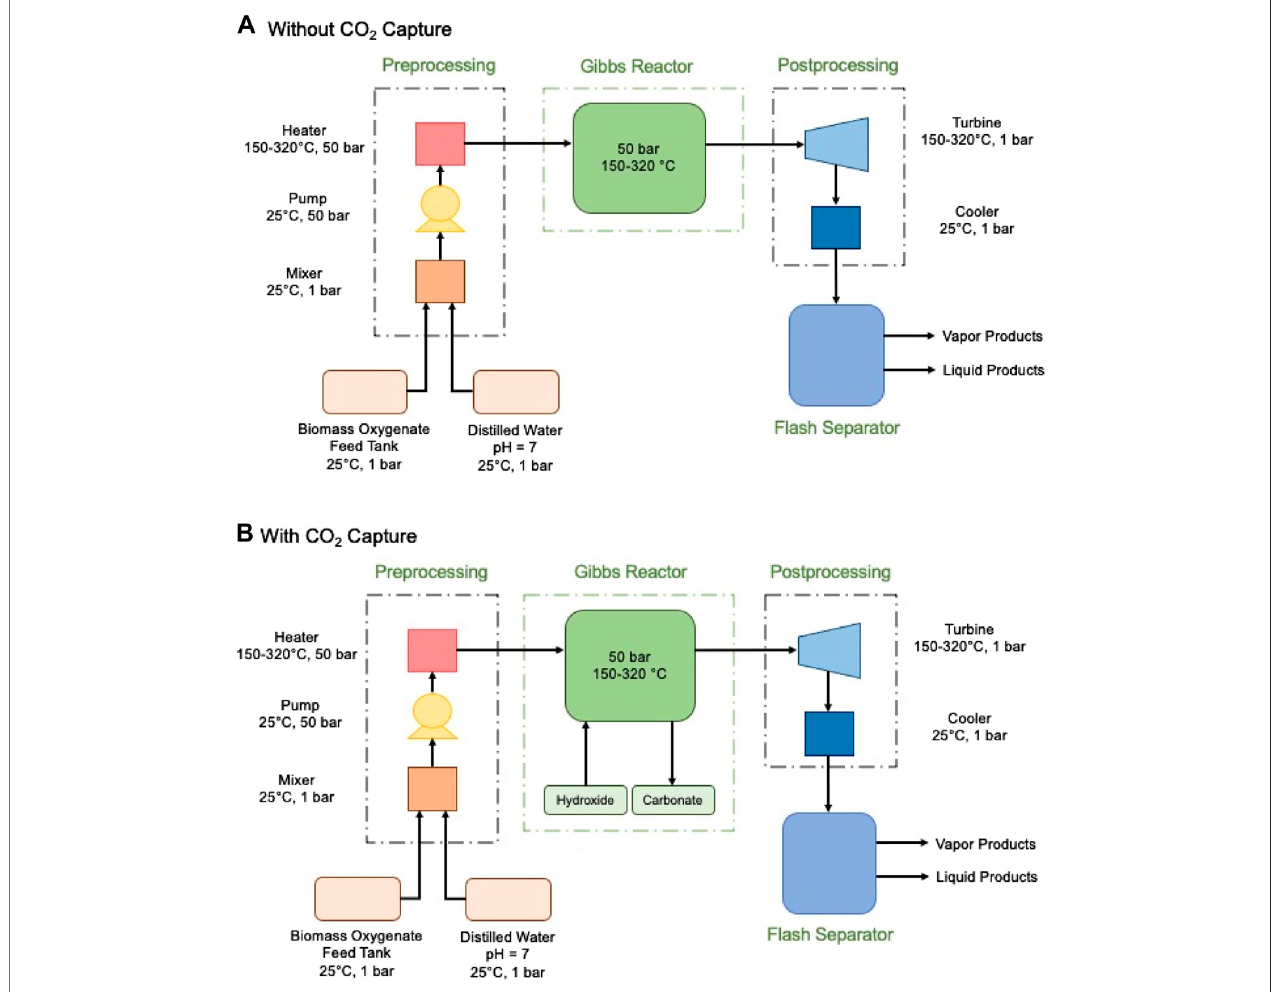
FIGURE 2 | Process fl ow diagram of simulation environment (A) without in-situ CO 2 capture, (B) with in-situ CO 2 capture. The thermodynamic feasibility of enhancing H 2 recovery with inherent carbon removal using aqueous biomass oxygenate sources are based on the reactions taking place in the Gibbs reactor.